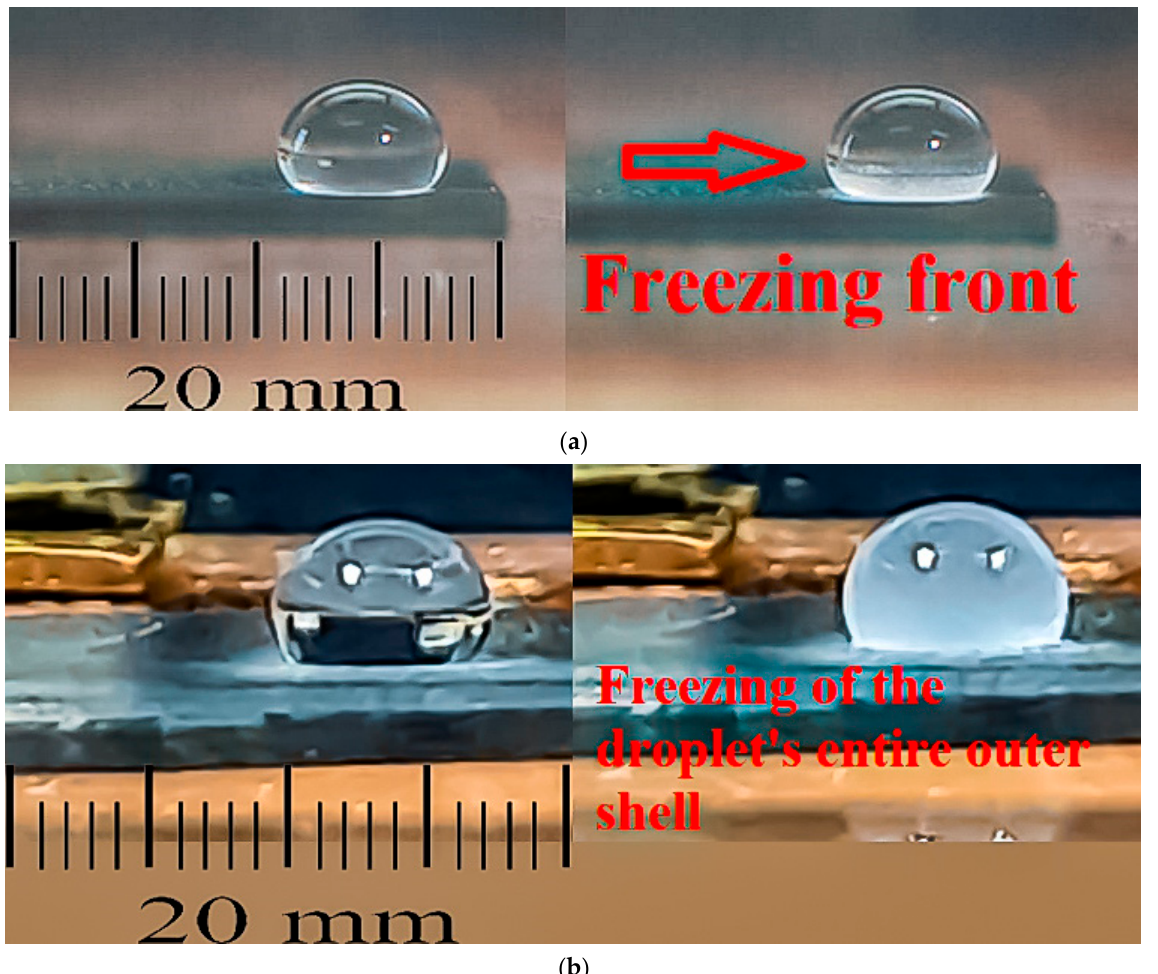
Figure 3. Photographs of ( a ) bulk and ( b ) contour freezing of 50 µ L water droplets resting on super-nonwettable carbon soot coatings.